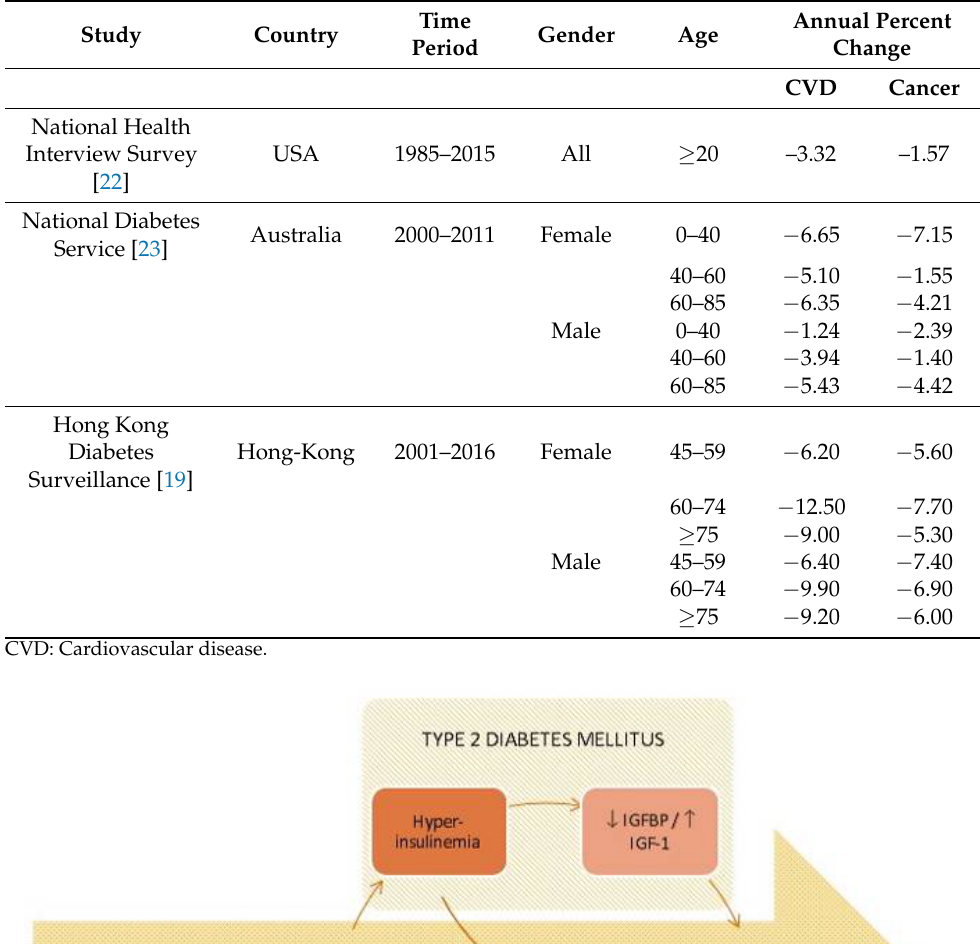
Table 1. Trends in cause-specific death in individuals with diabetes mellitus.